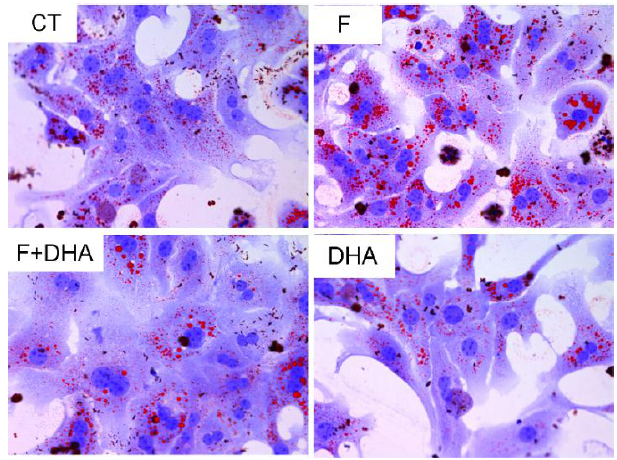
Figure 1. DHA ameliorates fructose induced TG accumulation in primary mouse hepatocytes Oil Red O staining. Original magnification: ×400; CT: control; F: fructose; F + DHA: fructose plus